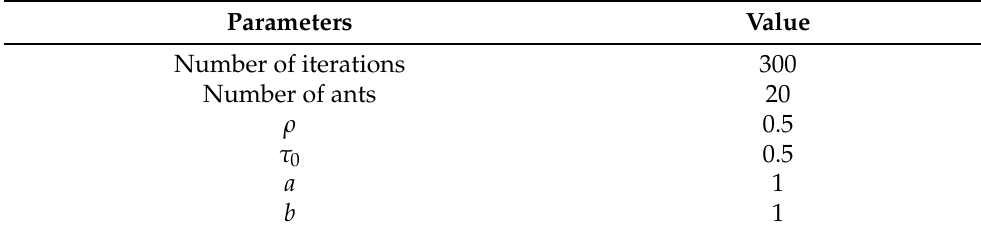
Table 1. ACO parameter settings.